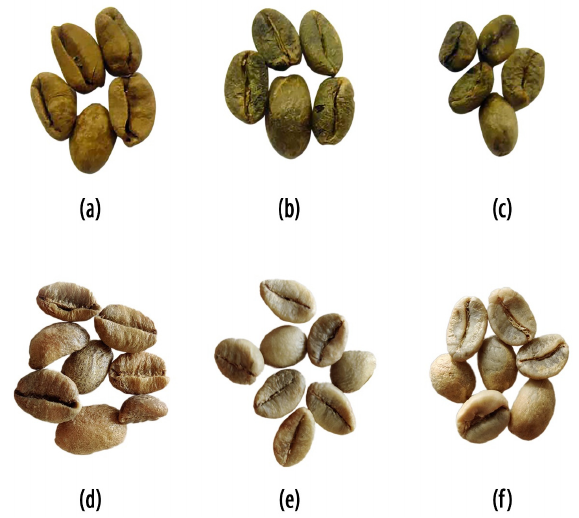
Figure 1. Photographs of coffees claimed as being digested: ( a ) Kopi Luwak coffee beans (claimed as being Coffea canephora var. robusta), ( b ) Nekemte-African Civet coffee beans, and ( c ) Abdela-African Civet coffee beans. Photographs of non-digested coffees for comparison: ( d ) Coffea liberica, ( e ) Coffea canephora var. Old Paradenia (India), and ( f ) Coffea arabica var. Catuaí Vermelho (Brasil). (( a – c ) reprinted with graphical improvement (background and noise removed) from Food Research International, 37, Massimo F. Marcone, Composition and properties of Indonesian palm civet coffee (Kopi Luwak) and Ethiopian civet coffee, pp. 901–912 [3], Copyright (2004), with permission from Elsevier. ( d – f ) are original photographs).